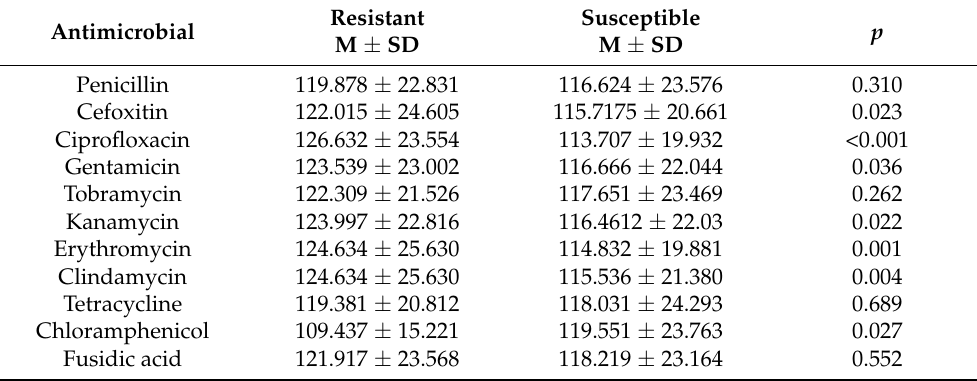
Table 2. Mean (M), standard deviation (SD) and univariate effects of biofilm formation by resistant to each antimicrobial.